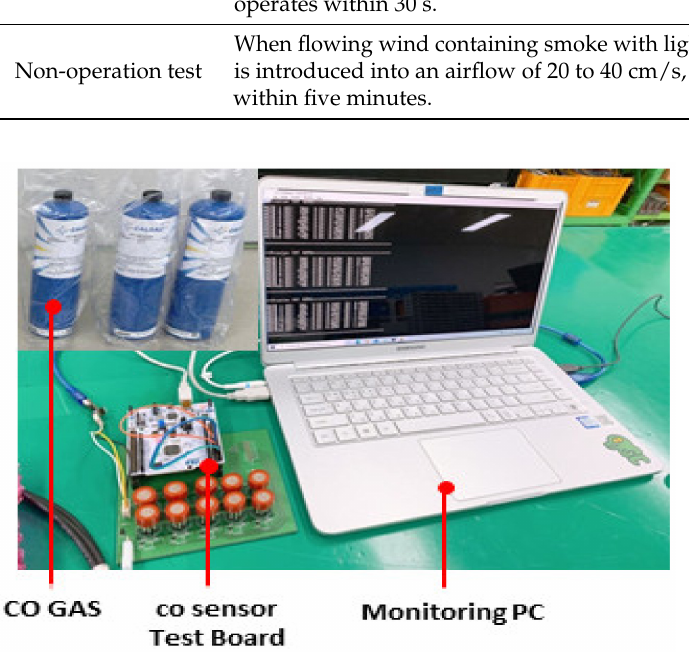
Figure 5. Verification experiment for quality accuracy of the CO